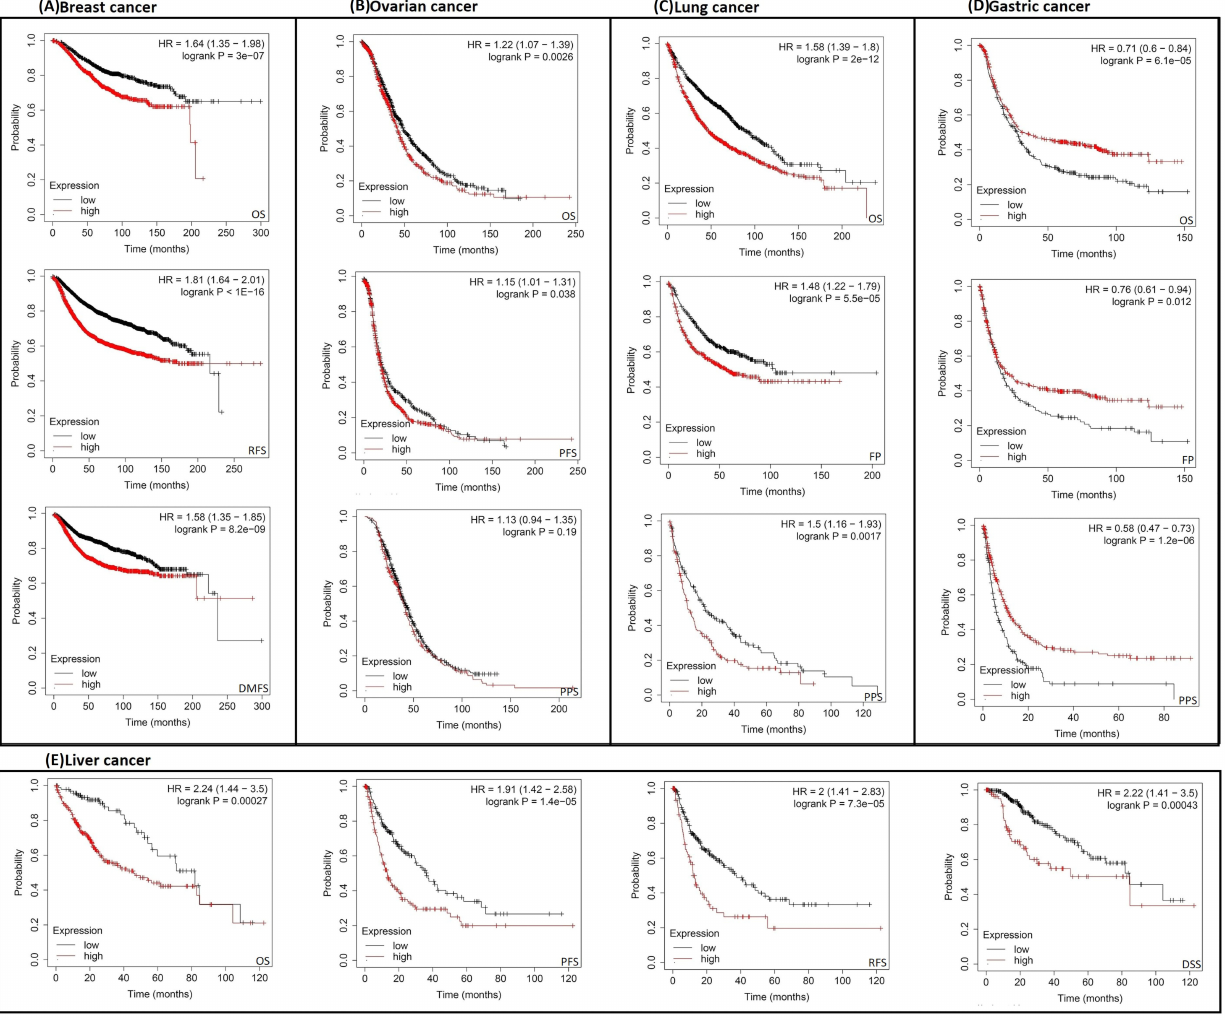
Figure 4. The correlation between RACGAP1 expression and the survival prognosis as assessed with the Kaplan–Meier plotter tool for ( A ) breast; ( B ) ovarian; ( C ) lung; ( D ) gastric; and ( D ) liver